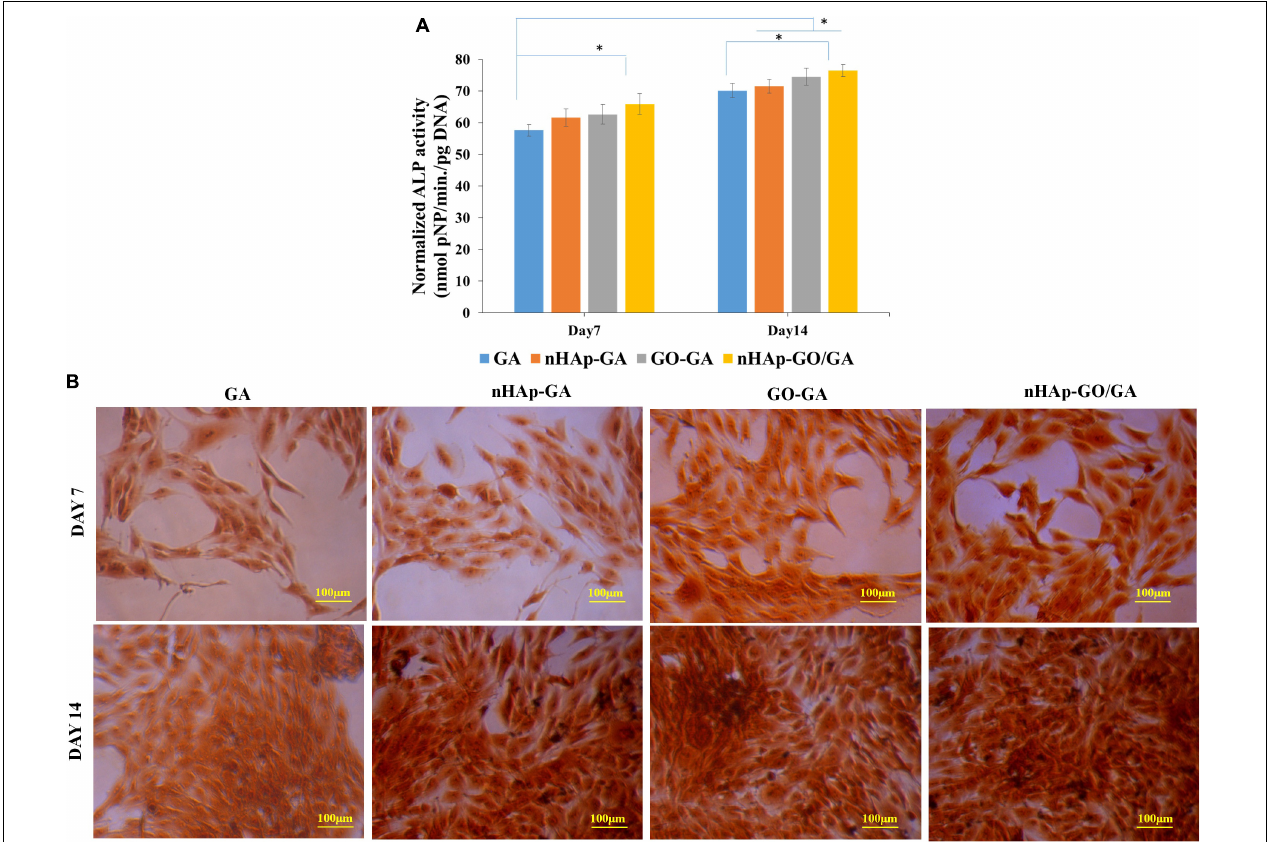
FIGURE 5 | Biological characterization of GA, nHAp-GA, GO-GA, and nHAp-GO/GA nanocomposite scaffolds: Quantitative analysis of ALP activity (A) , visual depiction of alkaline phosphatase activity over GA, nHAp-GA, GO-GA, and nHAp-GO/GA nanocomposite scaffolds by ALP assay kit on day 7 and day 14 (B) . Error bars and columns represent standard deviation and means. ∗ p < 0.05 indicate statistical